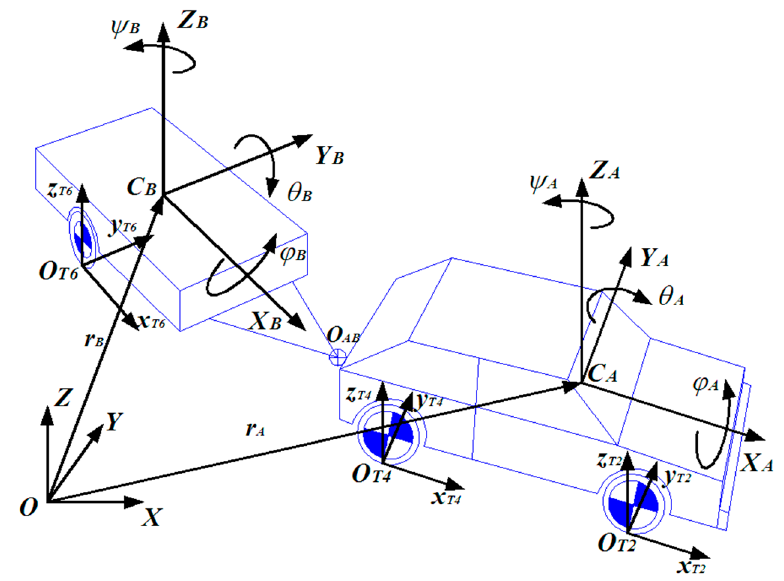
Figure 6. Model of a CT unit and the coordinate systems.